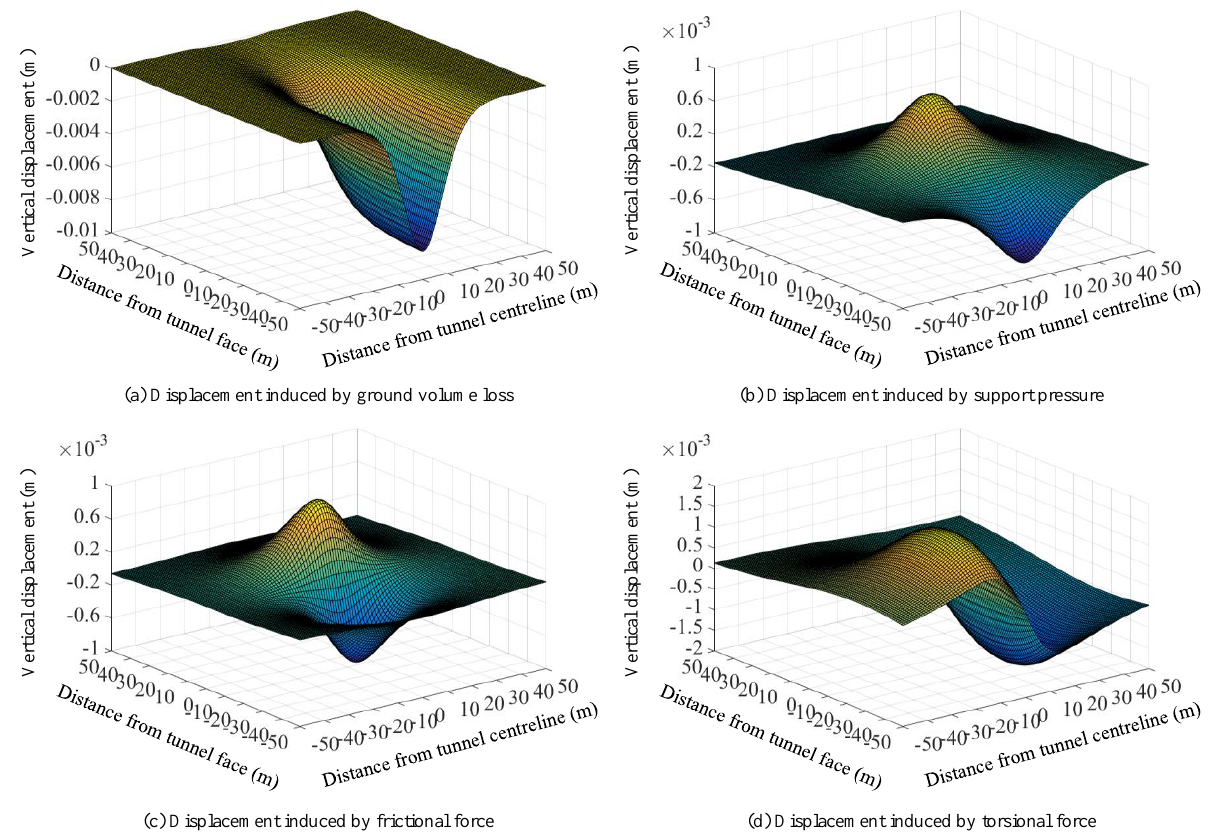
Figure 8. Ground deformations induced by different forces: ( a ) Displacement induced by ground volume loss; ( b ) displacement induced by support pressure; ( c ) displacement induced by frictional force; ( d ) displacement induced by torsional force.